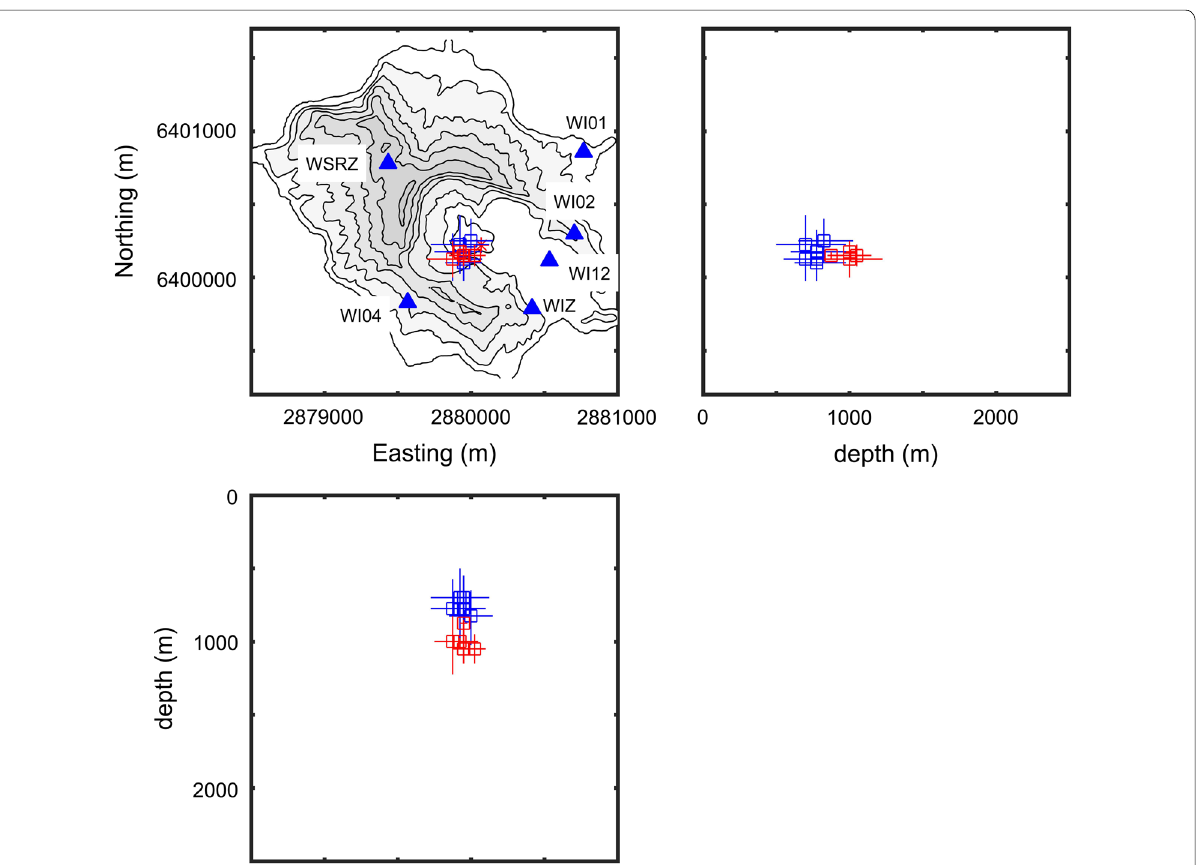
Fig. 5 Location and associated errors for pre-eruption (blue) and syn-eruption VLP (red) activity derived from moving window waveform semblance analysis. Each location is computed from a 1-min non-overlapping time window as shown in Fig. 4. Note the larger systematic error bars for shallower (pre-eruption) earthquakes. The data are summarized in Table